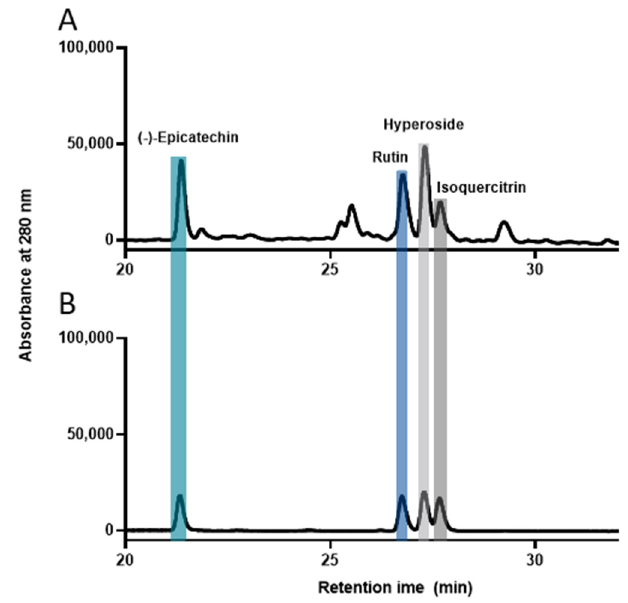
Figure 2. Chemical compounds of Camellia japonica leaf extracts (CJE). ( A ) High-performance liquid